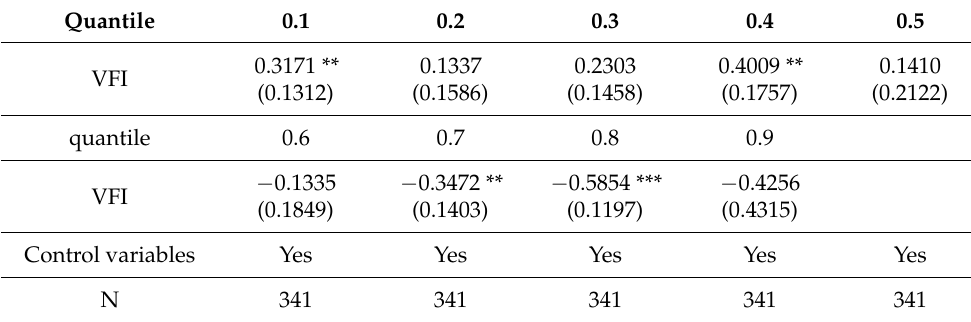
Table 7. Quantile regression